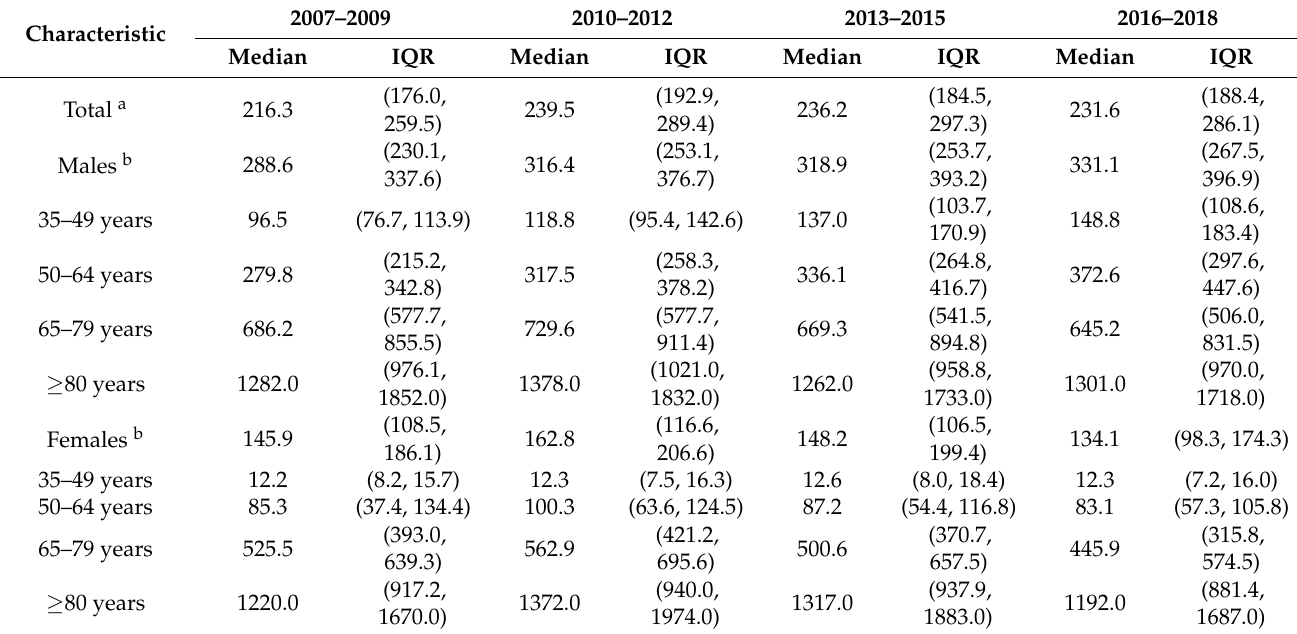
Table 1. The Incidence of Acute Myocardial Infarction by Township, 2007–2018 (per 100,000 population).